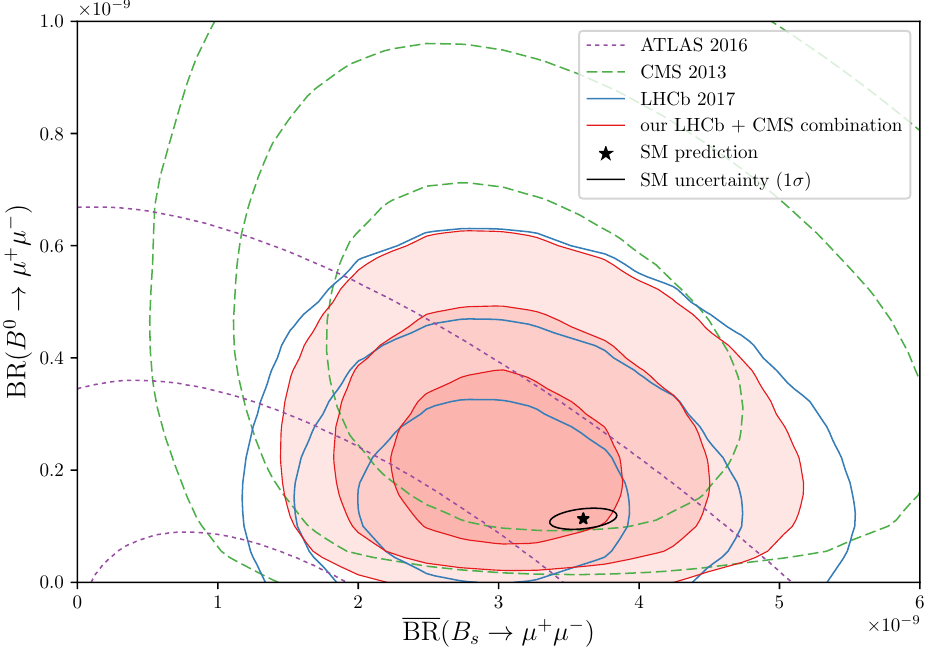
Figure 1 . Lines of constant likelihood at 1, 2, and 3 (cid:27) ( measurements at LHC experiments as well as for our \naive" combination of the Run 1 CMS measurement with the Run 1+2 LHCb measurement used in our numerics. Also shown are the SM predictions with their correlated 1 (cid:27)